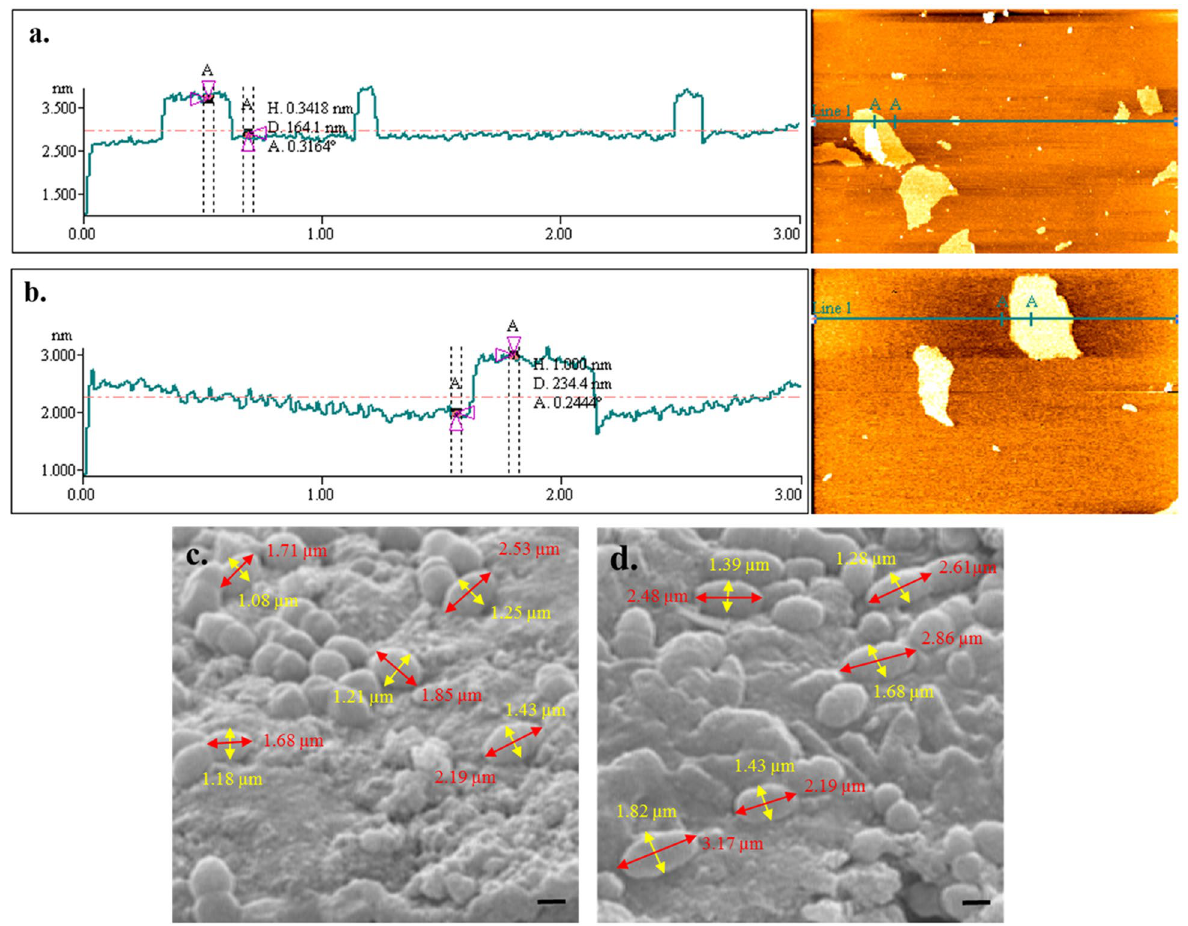
Figure 5. Images of binding of DNA-aptamer to the NGO ( a and b ) and binding of DNA-aptamer-NGO composite material to the P. gingivalis using AFM and SEM, respectively. NGO sheet thickness: 0.34 nm ( a ), DNA-aptamer-NGO thickness:1.00 nm ( b ), untreated P. gingivalis cells (length, 1.99 ± 0.36 μm; diameter, 1.23 ± 0.12 μm) with intact surfaces ( c ), and DNA-aptamer-NGO composite treated P. gingivalis (length,